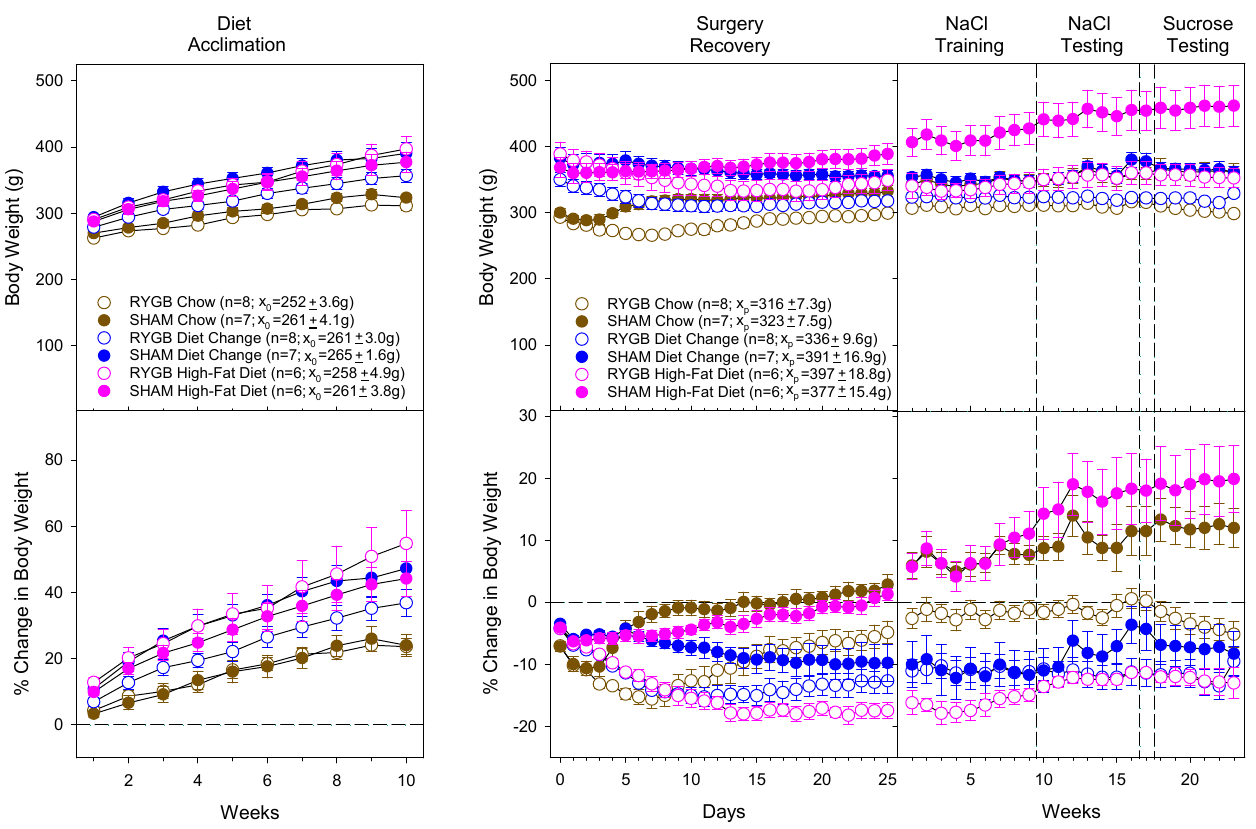
Figure 3. Mean ( ± SE, standard error) of body weight ( top panels) and percentage change in body weight ( bottom panels) of female rats during each of the critical periods. For the left panels, the mean body weight for each diet group on the first day of diet acclimation served as baseline (x 0 ; mean ± SE; left ) for percentage change analysis during the Diet Acclimation period. Week 1 reflects the change in body weight from the first day of the diet acclimation period. In the right panels, mean body weight on the day before surgery served as baseline (x p ; mean ± SE; right ) for percentage change comparisons for the remainder of the experiment. Day 0 reflects the food-deprived body weight of animals on the day of surgery. RYGB animals are represented by open circles and SHAMs by filled circles. Brown symbols represent the Chow group; blue, the diet change; pink, the high-fat